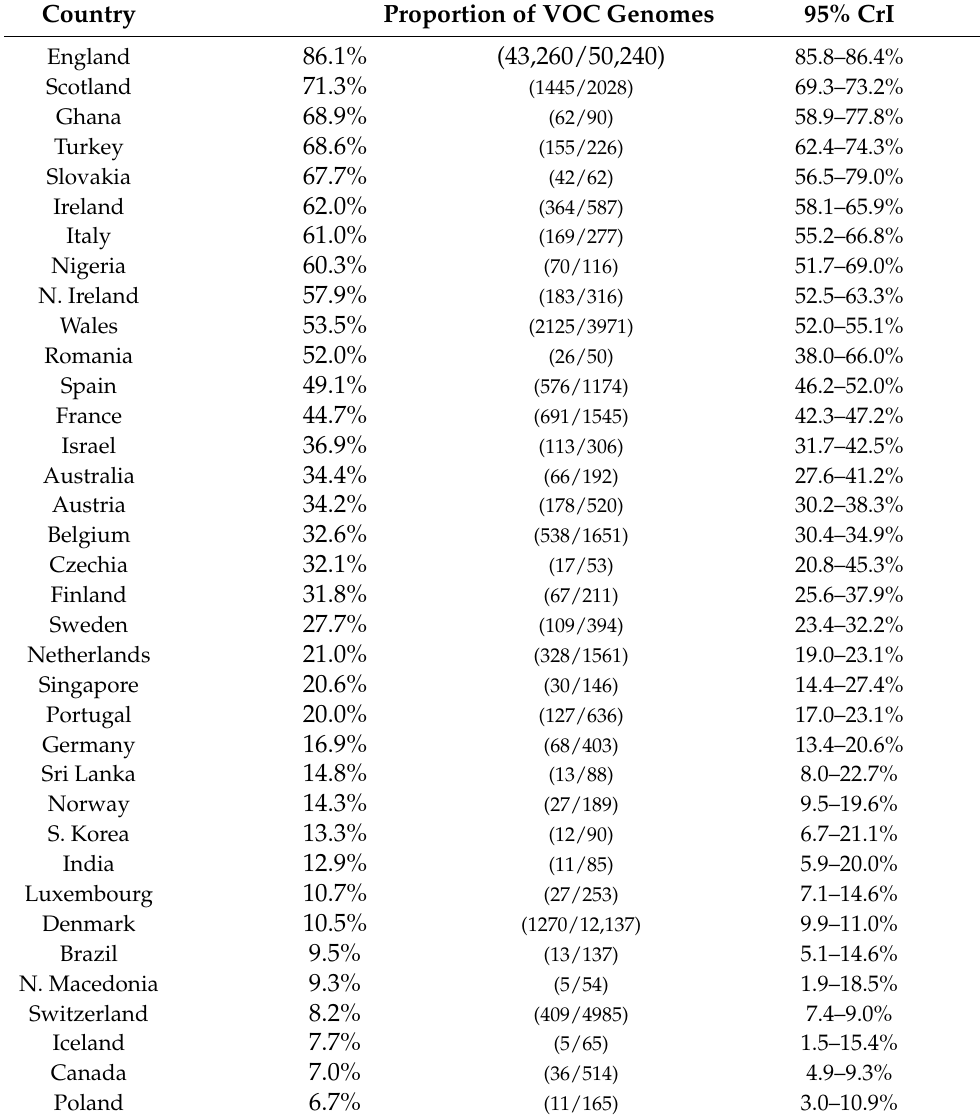
Table 1. Fraction of VOC genomes in countries that in January 2021 reported more than 50 genomes.